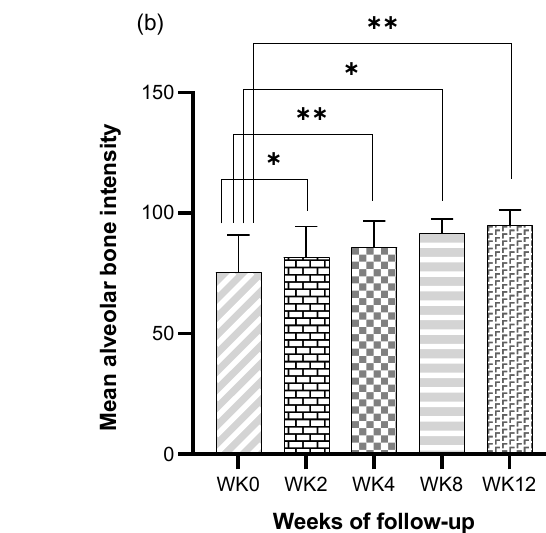
Figure 9. Comparison of alveolar bone regeneration parameters including new alveolar bone height ( a ) and alveolar bone intensity ( b ) among the day of operation and 2nd (WK2), 4th (WK4), 8th (WK8) and 12th weeks (WK12) after operation. An asterisk and two asterisks on top of a bar indicate a statistically significant difference at a p -value of 0.05 and a p -value of 0.01, respectively.